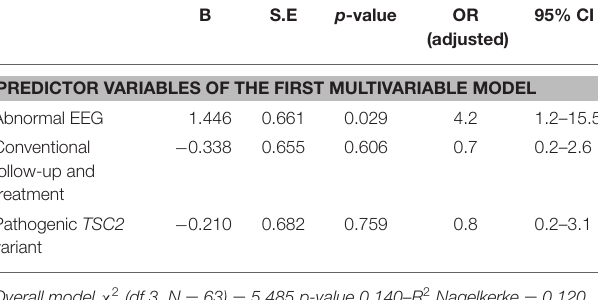
TABLE 2 | Multivariable logistic regression models predicting ASD symptoms at the age of 24